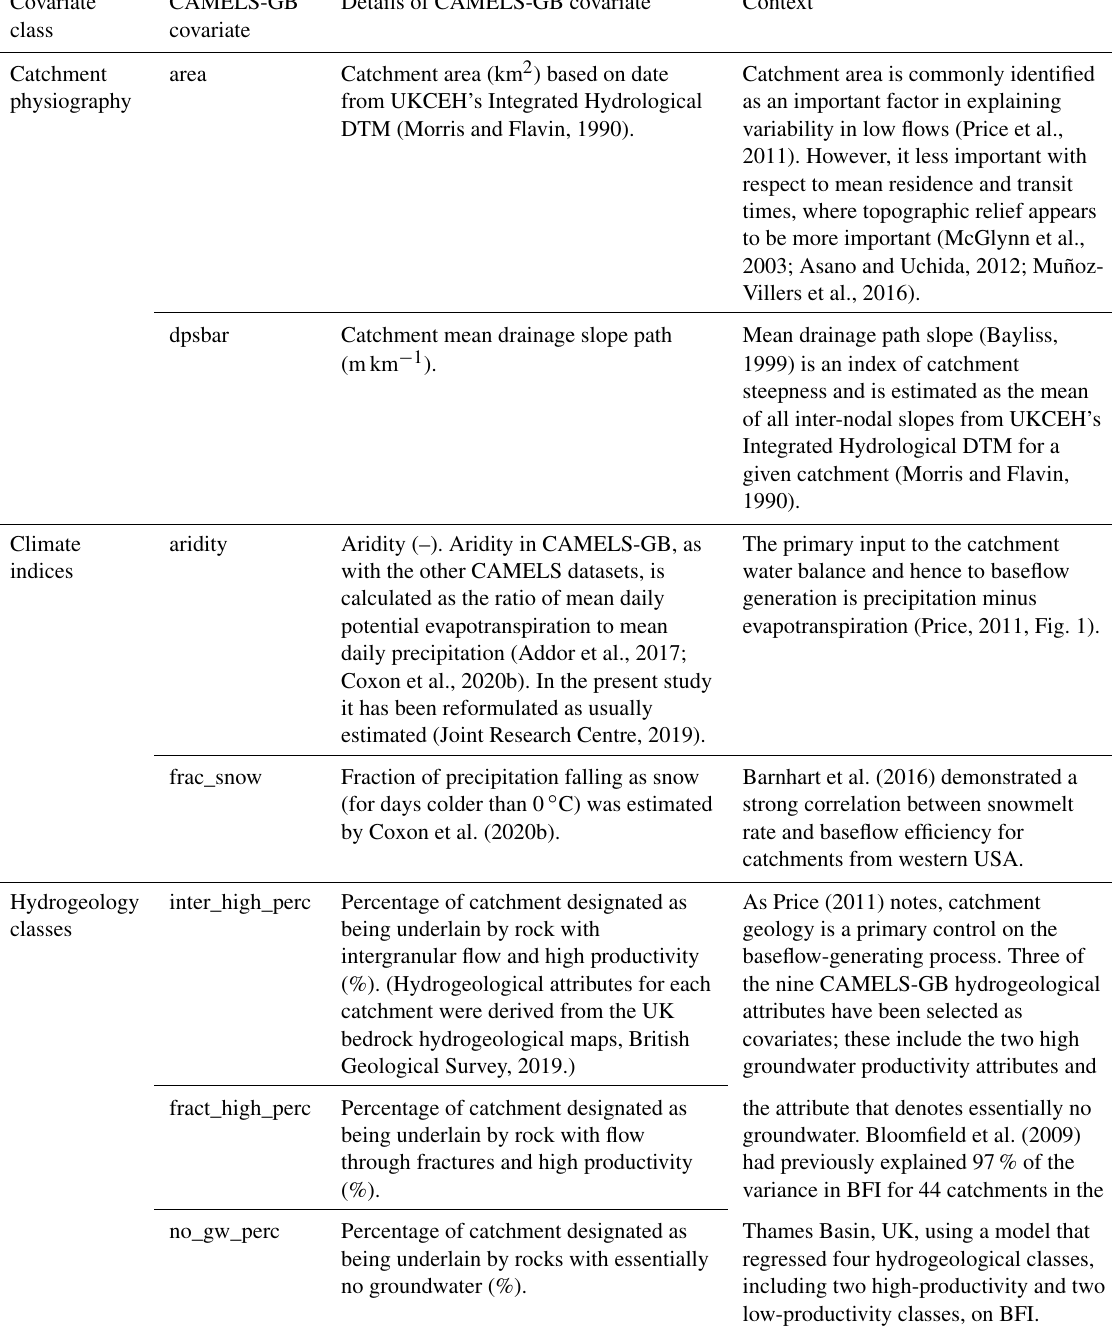
Table A1. Description of the CAMELS-GB covariates used in the modelling and analysis.